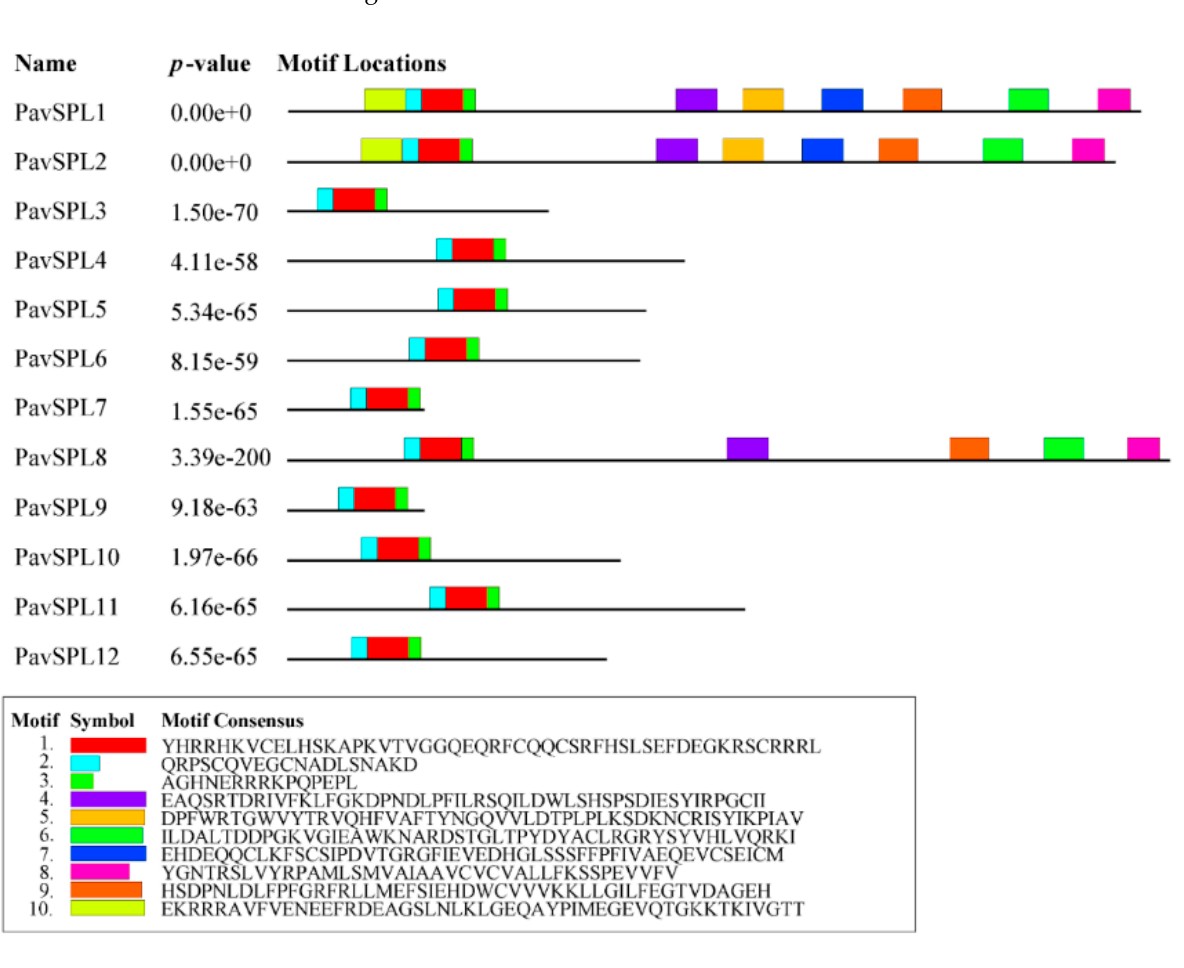
Figure 5. Gene structure of PavSPL genes in the online Gene Structure Display Server (GSDS). 2.5. Cis-Acting Elements in the Promoters of PavSPL Genes Many cis-acting elements on the promoter were distributed upstream of the gene coding sequence, which can regulate the expression characteristics of the genes. Predicting hormone response elements, stress response elements, and light response elements on the are 2000 bp upstream of the PavSPL promoter sequence (Figure 6). All 12 PavSPLs promoter sequences have hormone response elements, which may play a critical role in the hormone balance in sweet cherries. The element corresponded to five phytohormones, including ABA, MeJA, salicylic acid (SA), GA, and auxin. Most were ABA response elements, indicating that the PavSPL genes played a role in the ABA responses.